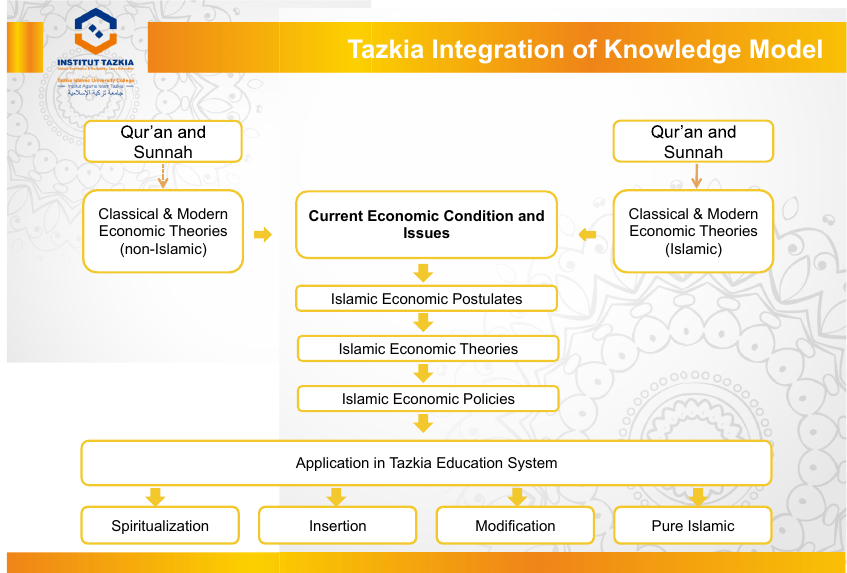
Figure 1. Tazkia integration of knowledge